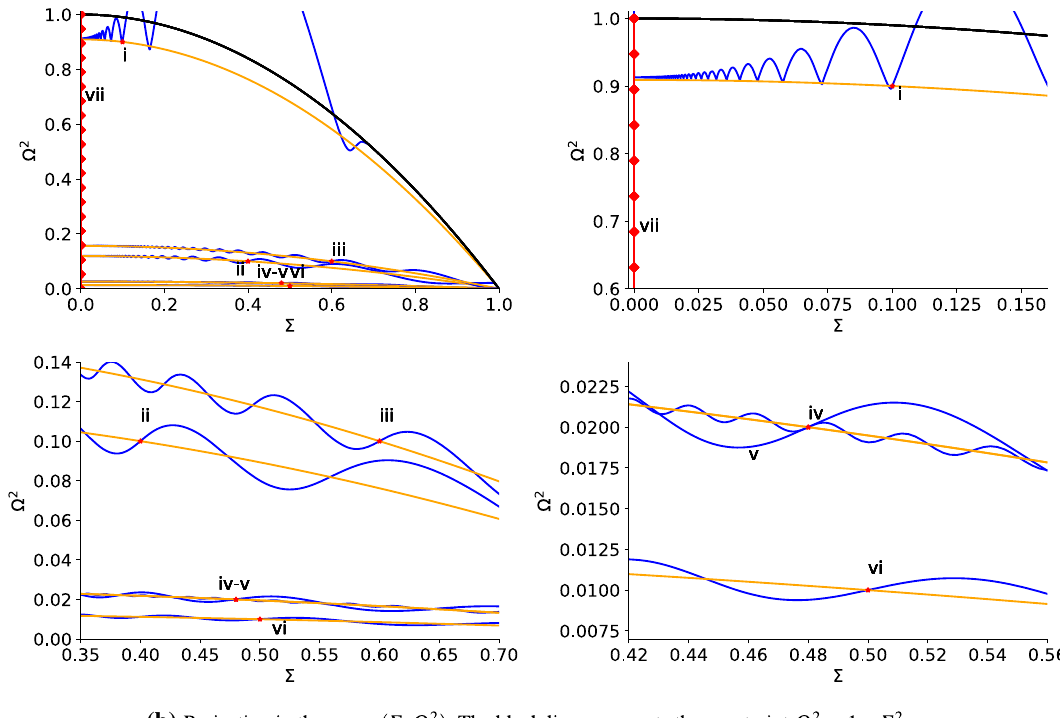
Fig. 4 Some solutions of the full system (44) (blue) and time-averaged system (72) (orange) for Bianchi I metric when γ = 1. The line denoted by red diamonds corresponds to the attracting line of equilibrium points. We have used for both systems the initial data sets that are presented in Table